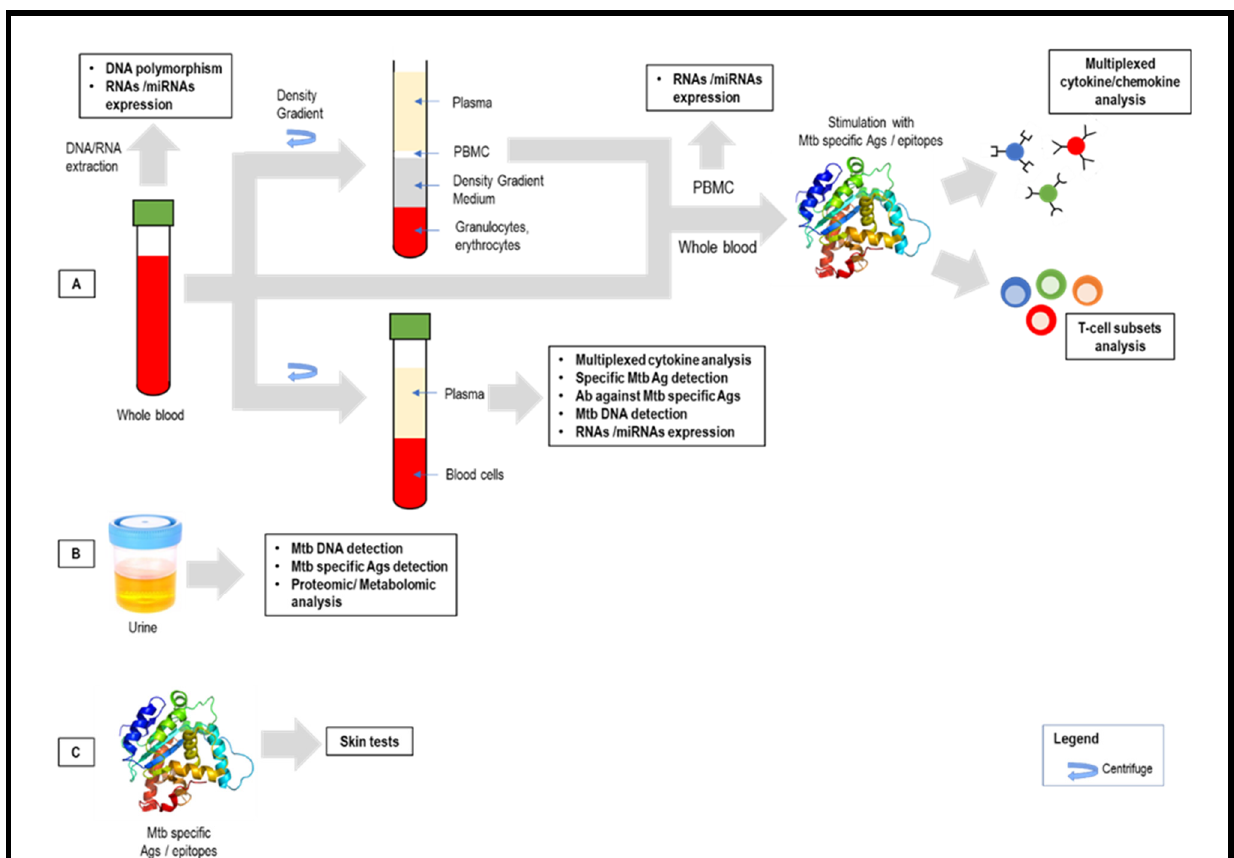
Figure 2. Summary of proposed tests for TBI diagnosis improvement using blood ( A ), urine ( B ), and Mtb specific skin tests ( C ).